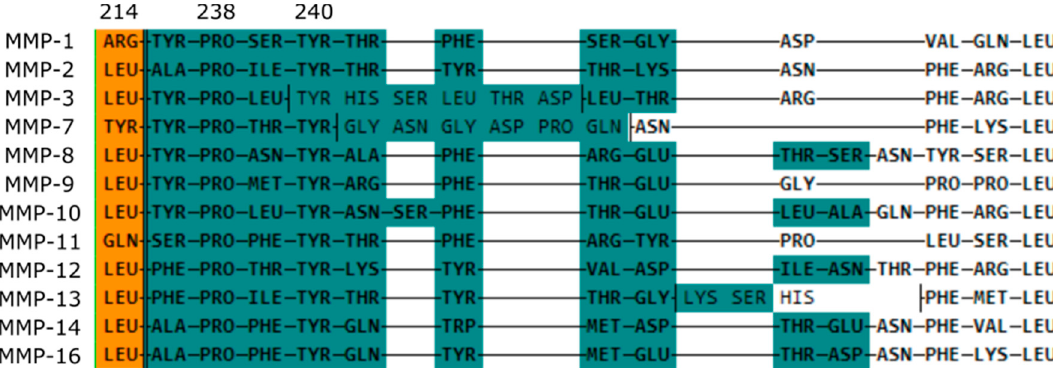
Figure 4. ( a ) Ribbon structure of catMMP-13 (PDB ID: 2OW9) [73] showing five beta-sheets and three alpha-helices (catalytic zinc(II) ion as blue and structural zinc(II) ion as cyan sphere, calcium(II) ions as brown spheres), ( b ) electrostatic surface of catMMP-13 with the substrate recognizing groove.